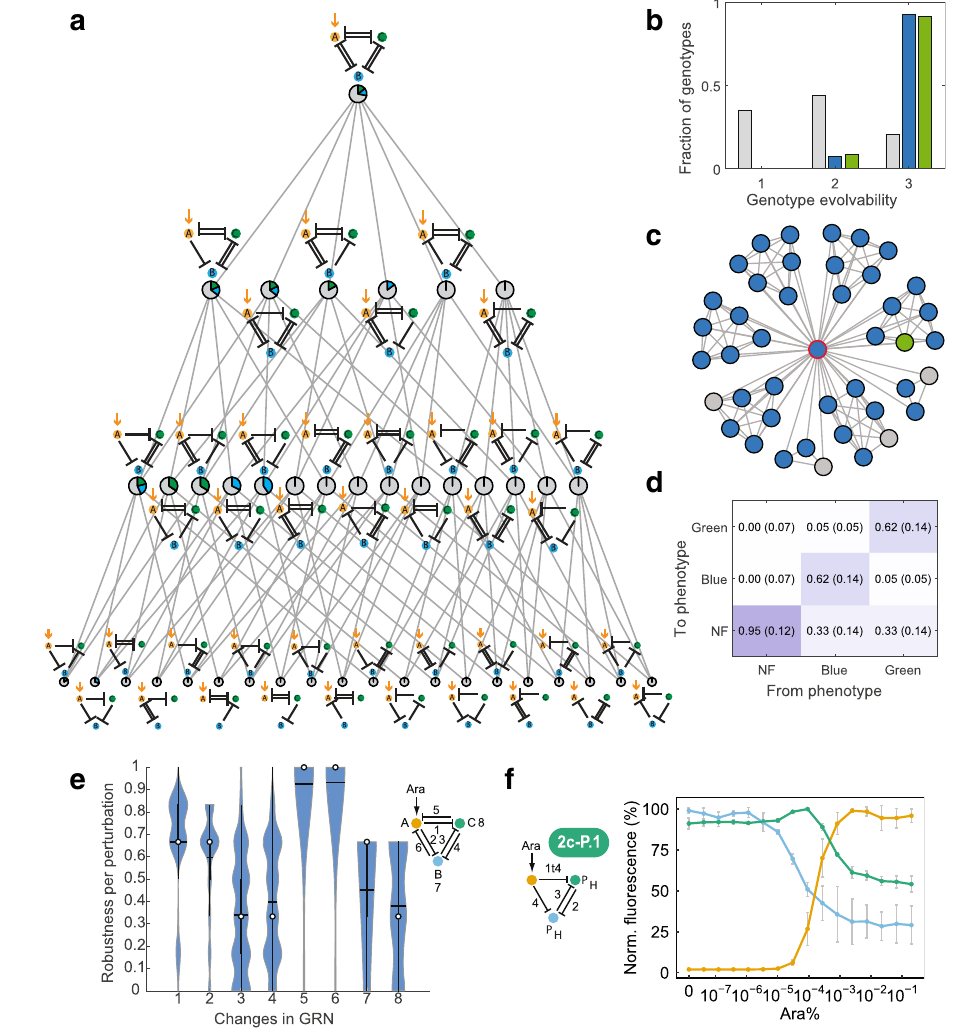
Fig. 4 | Model-predicted robustness and evolvability. a Network topologies (schemesasinFig.1)andtheirneighborrelations(greylinesindicatingthatGRNsin two topologies are reachable by a single mutation). Pie charts indicate fractions of GRNs (genotypes) with BLUE-stripe (blue), GREEN-stripe (green) and non- functional (NF; grey) phenotype per topology. b Distributions of evolvability (number of phenotypes in the 1-neighborhood of a genotype) for genotypes with BLUE, GREEN, and NF phenotype (colors as in a ). c Example subgraph for the red- circled node with evolvability 3 and its direct neighbors (37 BLUE-, 1 GREEN-stripe and 4 NF, colors as in a ). d Transition frequencies (median, interquartile range